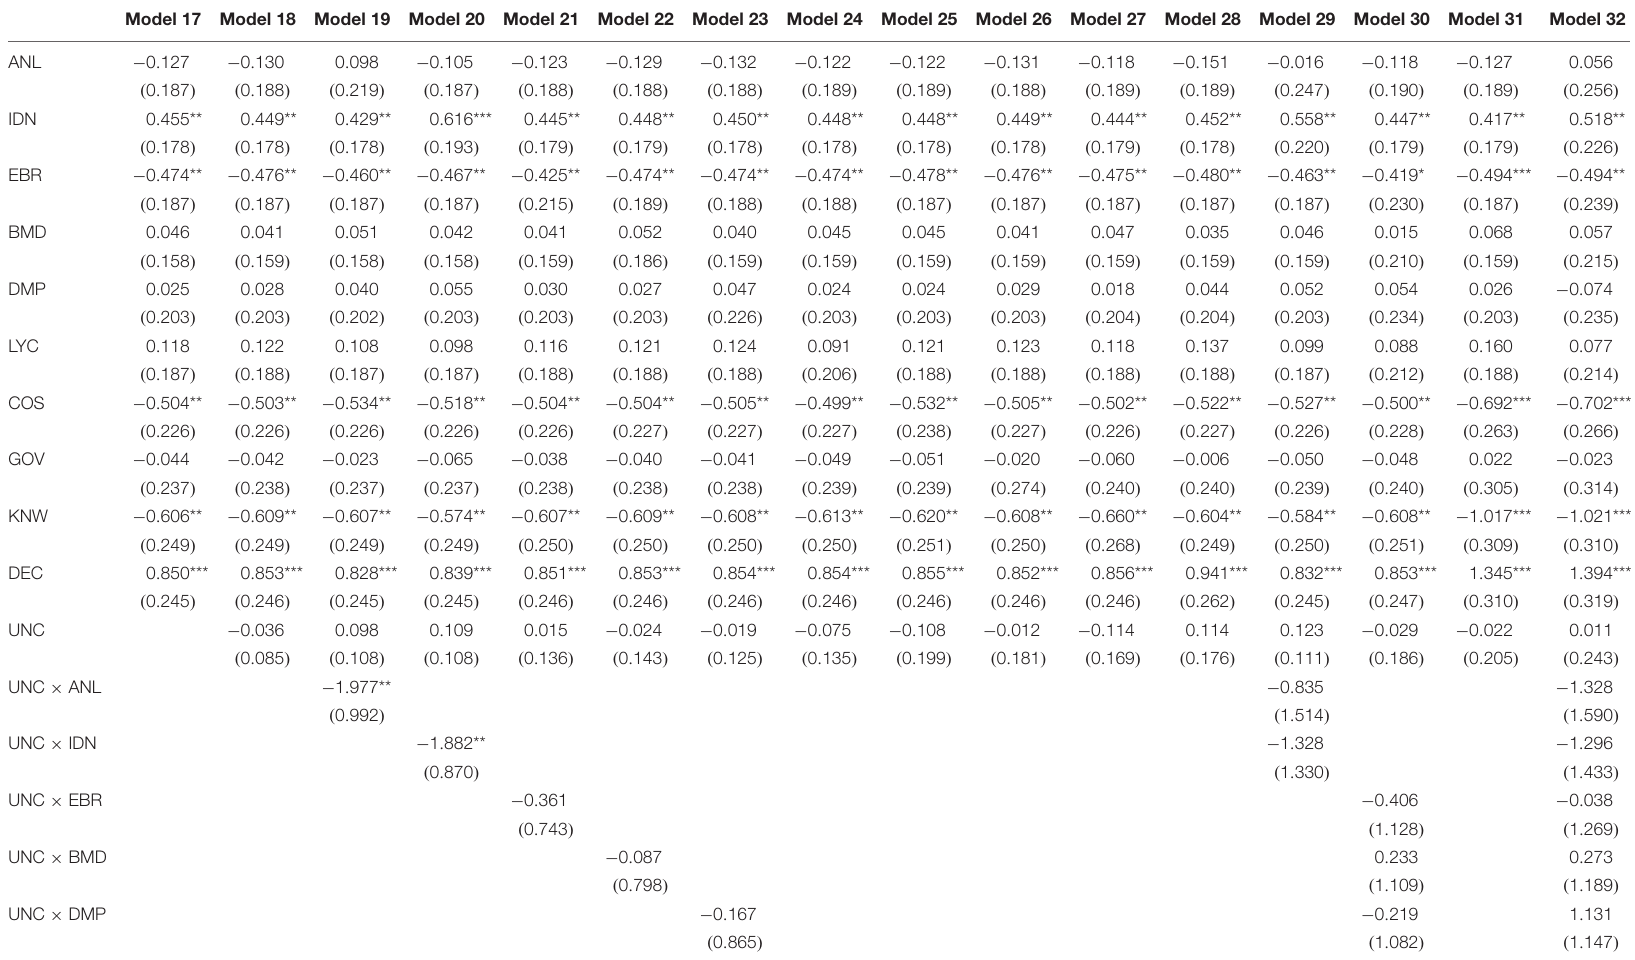
TABLE 6 | Fixed effect panel model estimation of the impact of DCV and environmental uncertainty on Tobin’s